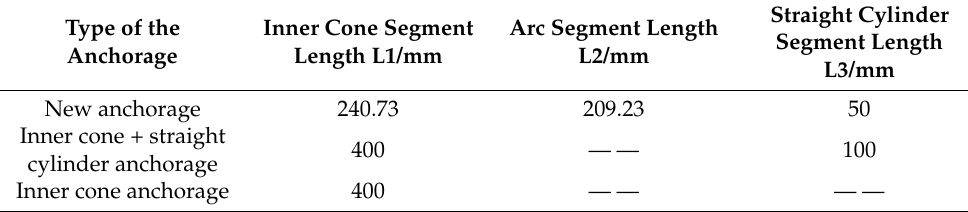
Table 4. Geometric parameters of three